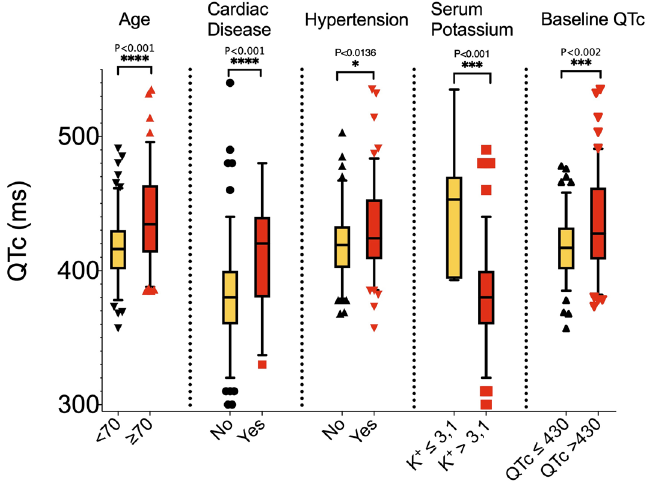
Figure 2. Representation of QTc interval of relevant variables associated with the presence of a QTc > 460 ms (cardiac disease, age, hypertension and the previous treatment with antidepressants).